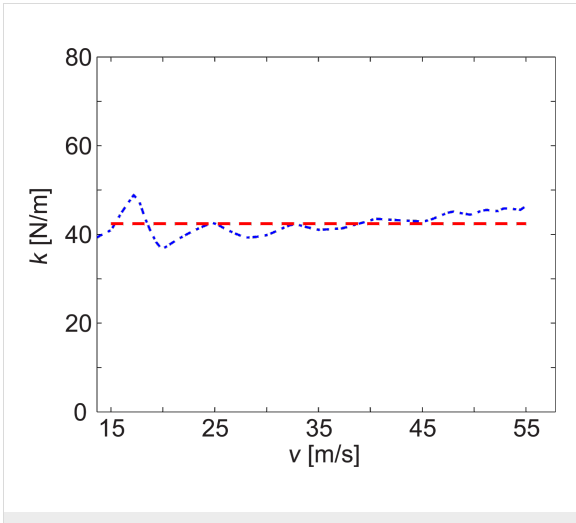
To properly normalize the curve to zero deflection, the photo- diode signal value at very low speeds was subtracted. Subse- quently, Equation 3 was used to determine . The result is shown in Figure 6. The highest deflection of NCHV was ≈ 52 nm in our experiments and therefore well within the linear response range of the cantilever [38].